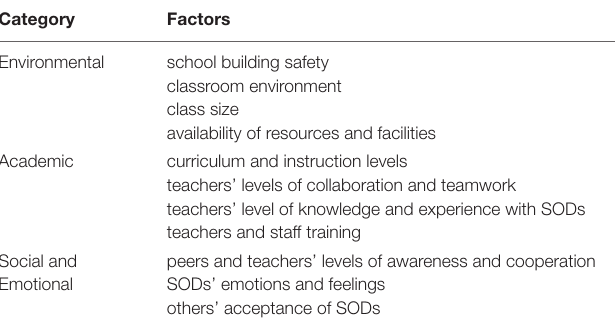
TABLE 2 | Categories of internal school-based factors that affect the inclusion of students of determination.